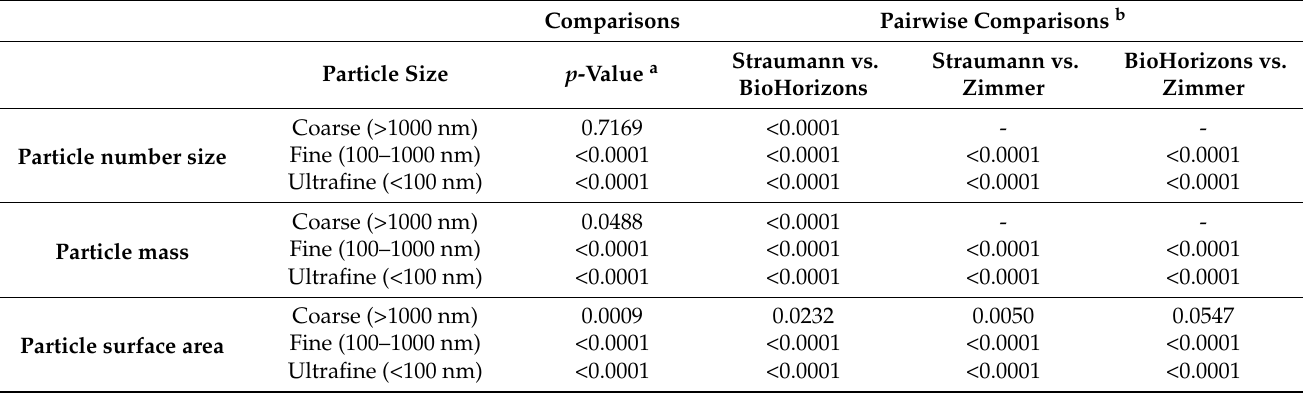
Table 2. Size distribution comparison among implant manufacturers stratified by particle size (particle number size; particle mass; particle surface area).